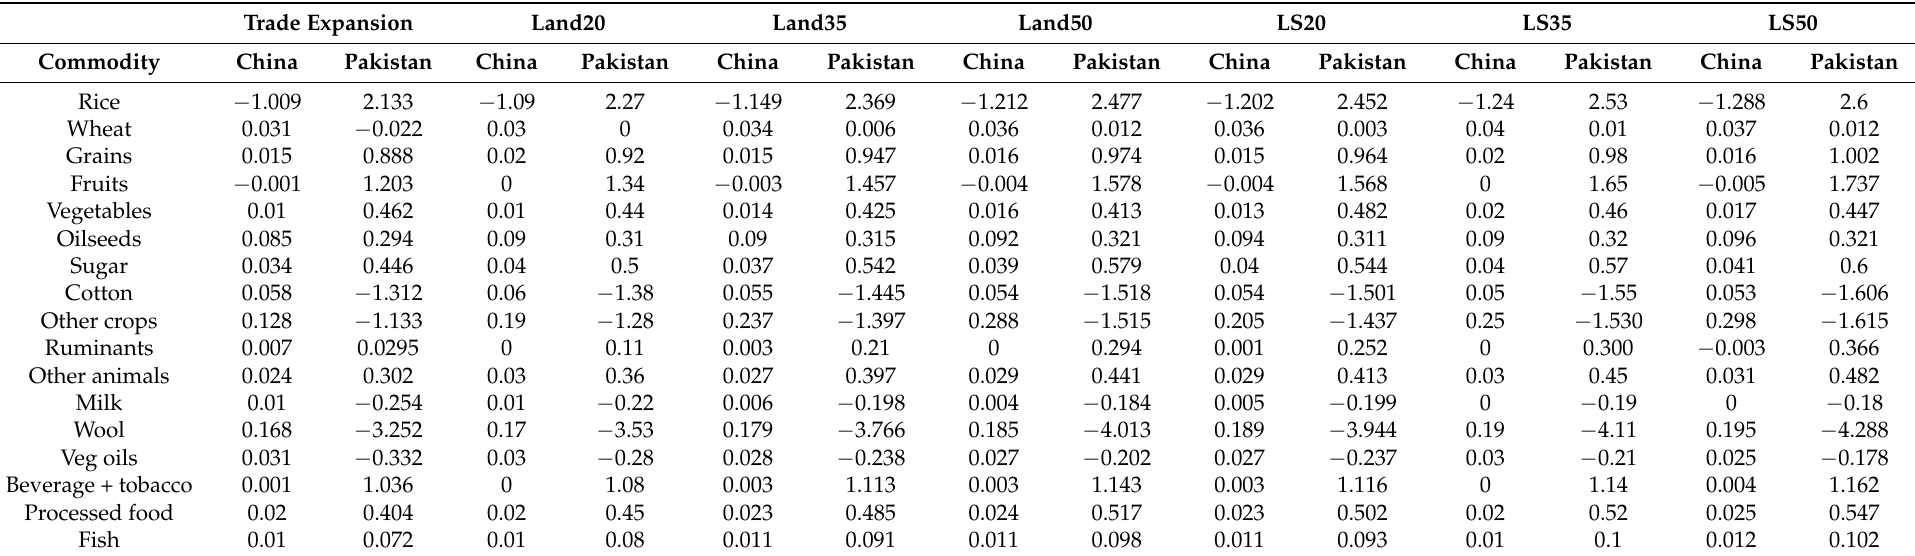
Table 4. Effects on outputs of agricultural sectors in Pakistan and China (%). Trade